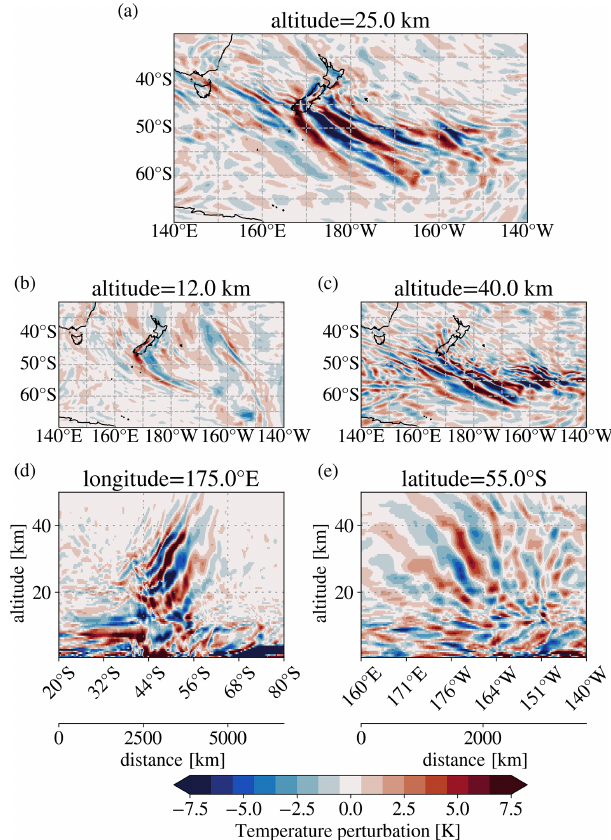
Figure 2. Horizontal (a–c) and vertical (d, e) cross sections of tem- perature perturbations found in the ECMWF-IFS temperature field on 1 August 2014 at 12:00UTC. Horizontal cross sections are at (a) z = 25, (b) z = 12, and (c) z = 40km altitude. Vertical cross sections show cuts along the meridian of (d) 175 ◦ E and the lati- tude circle of (e) 55 ◦ S. The temperature perturbations in the vertical cross sections are scaled with a factor of exp erence altitude z 0 = 25km, assuming a scale height of H = 7km, to highlight the vertical phase line